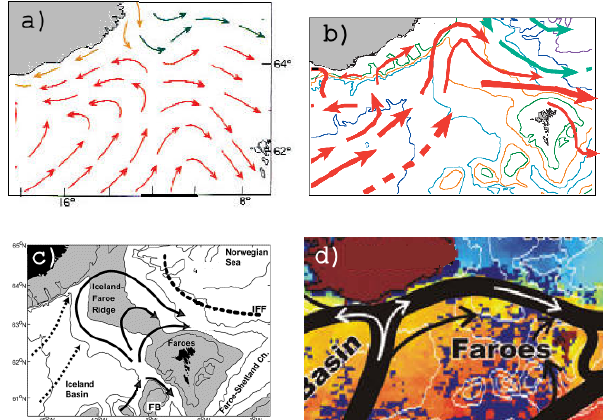
Fig. 19. Different interpretations of the Atlantic Water flow (red or black arrows) between Iceland and the Faroe Islands: (a) from Ste- fánsson and Ólafsson (1991), (b) from Valdimarsson and Malmberg (1999) based on drifter data, (c) the classical view of Atlantic Water pathways (unbroken arrows) and “alternative suggestions” (broken arrows) from Hansen et al. (2003), (d) the Atlantic Water pathways suggested by Orvik and Niiler (2002) based on drifter data. Modi- fied after Stefánsson and Ólafsson (1991), Valdimarsson and Malm- berg (1999), Orvik and Niiler (2002), and Hansen et al. (2003).